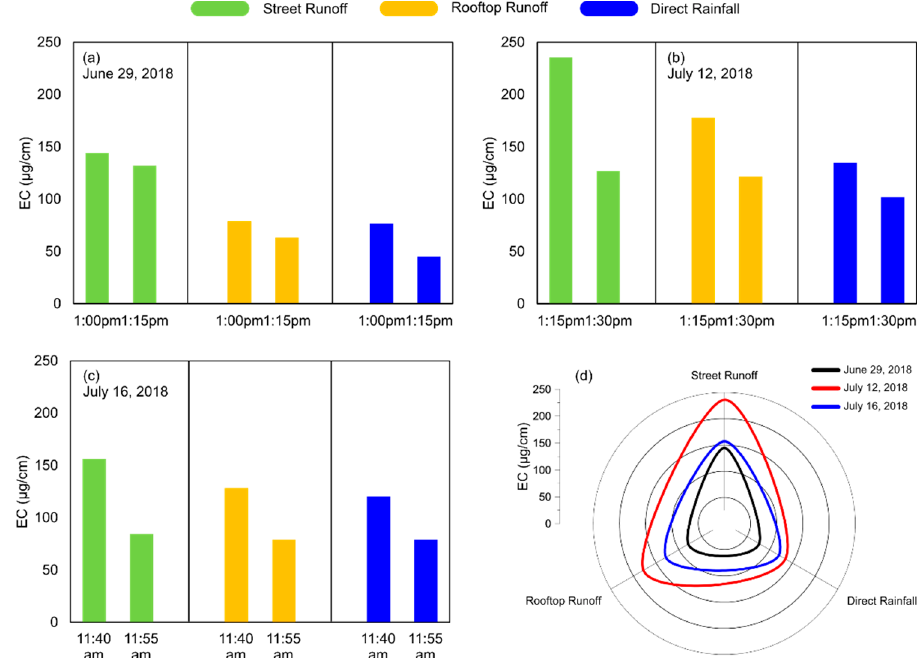
Figure 3. Profile of electrical conductivity (µg/cm) in harvested rainwater at Site S1—Irrigation Research Institute, Irrigation Department, Lahore, Pakistan, where ( a ) represents 29 June 2018, ( b ) represents 12 July 2018, ( c ) represents 16 July 2018, and ( d ) illustrates comparative analysis of the three selected dates on polar chart.